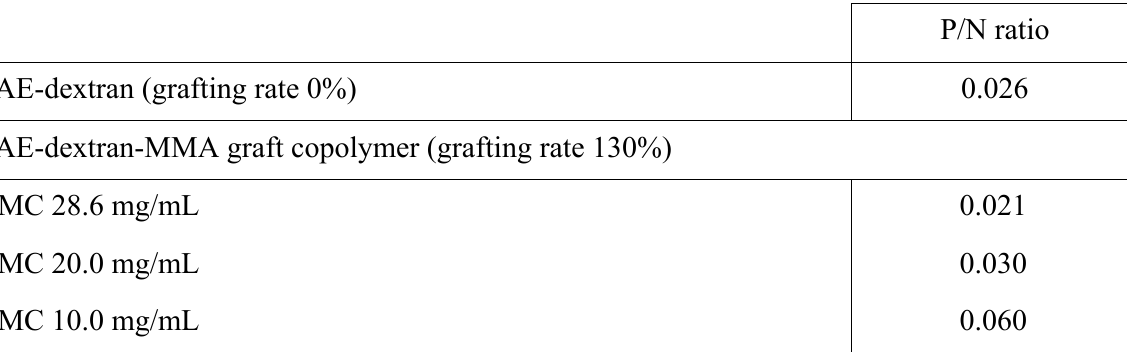
Table 1. Charge ratios (P/N) of DEAE-dextran-MMA graft copolymer (DDMC) and DEAE-dextran to